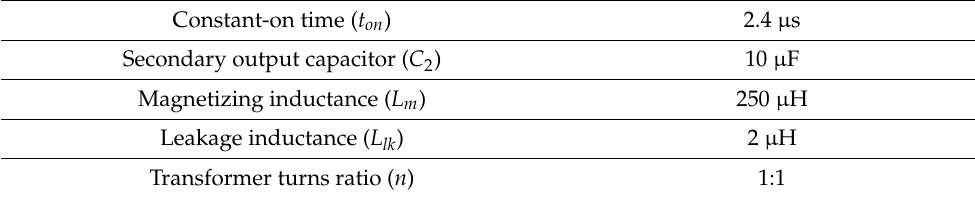
Table 2. Design parameters of the COT controlled fly-buck converter. Constant-on time ( t on